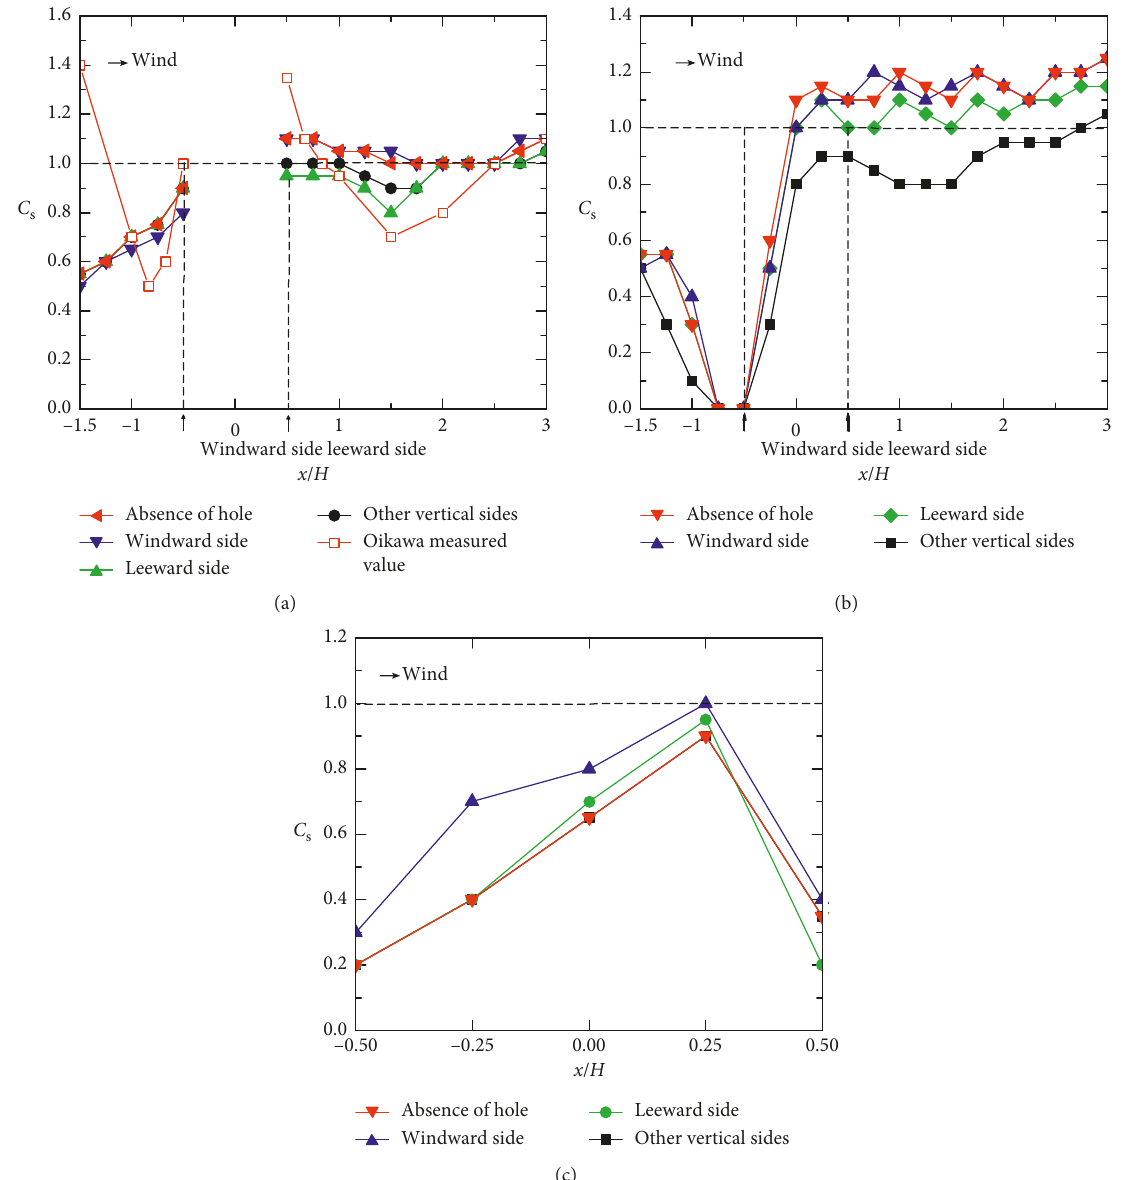
Figure 10: Snow distribution curve of a single cube: (a) along central and (b) longitudinal axes and (c) model surface. Inlet